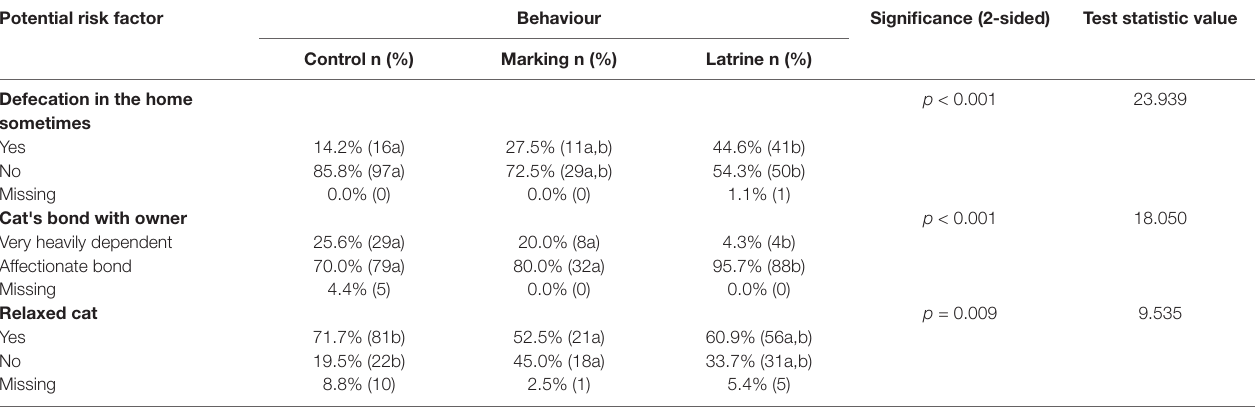
TaBle 5 | Significant potential risk factors (Chi square test) for marking and latrine related to cat's behavioural and medical